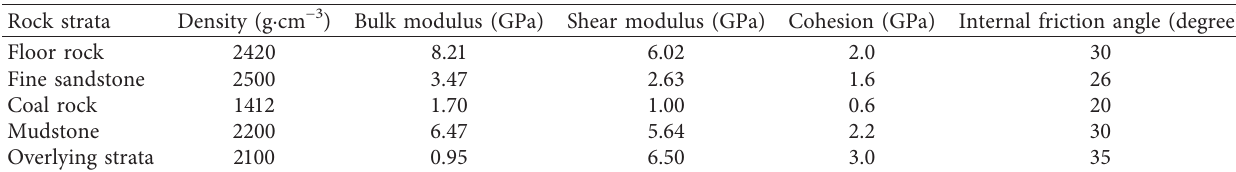
Figure 2: Numerical calculation model. Table 1: Physical and mechanical parameters of